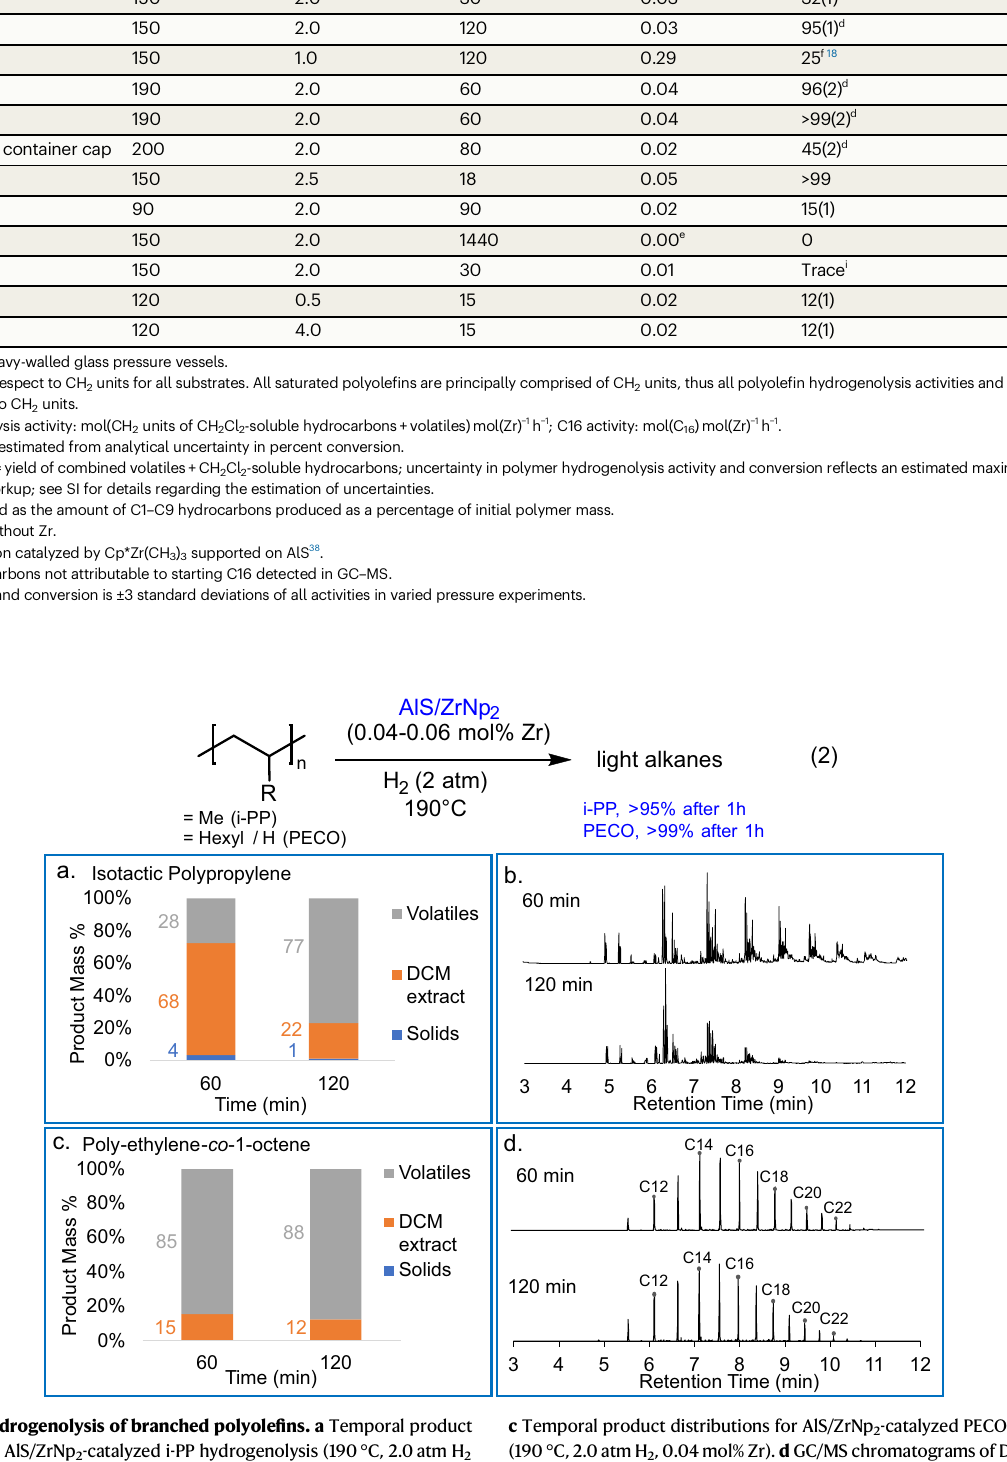
Entry Substrate